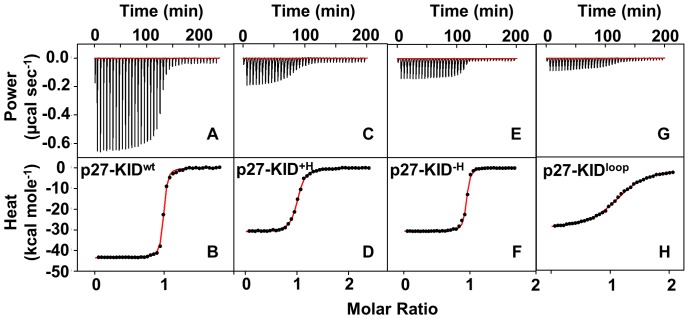
Isothermal titration calorimetry.Raw titration calorimetry data and binding isotherms, respectively, for (a, b) p27-KIDwt, (c, d) p27-KID+H, (e, f) p27-KID−H, and (g, h) p27-KIDloop binding to Cdk2/cyclin A.